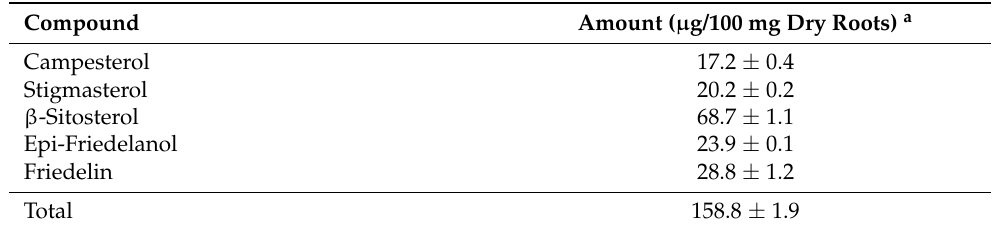
Table 2. Content of the main bioactive compounds present in aeroponic C. Sativa roots.